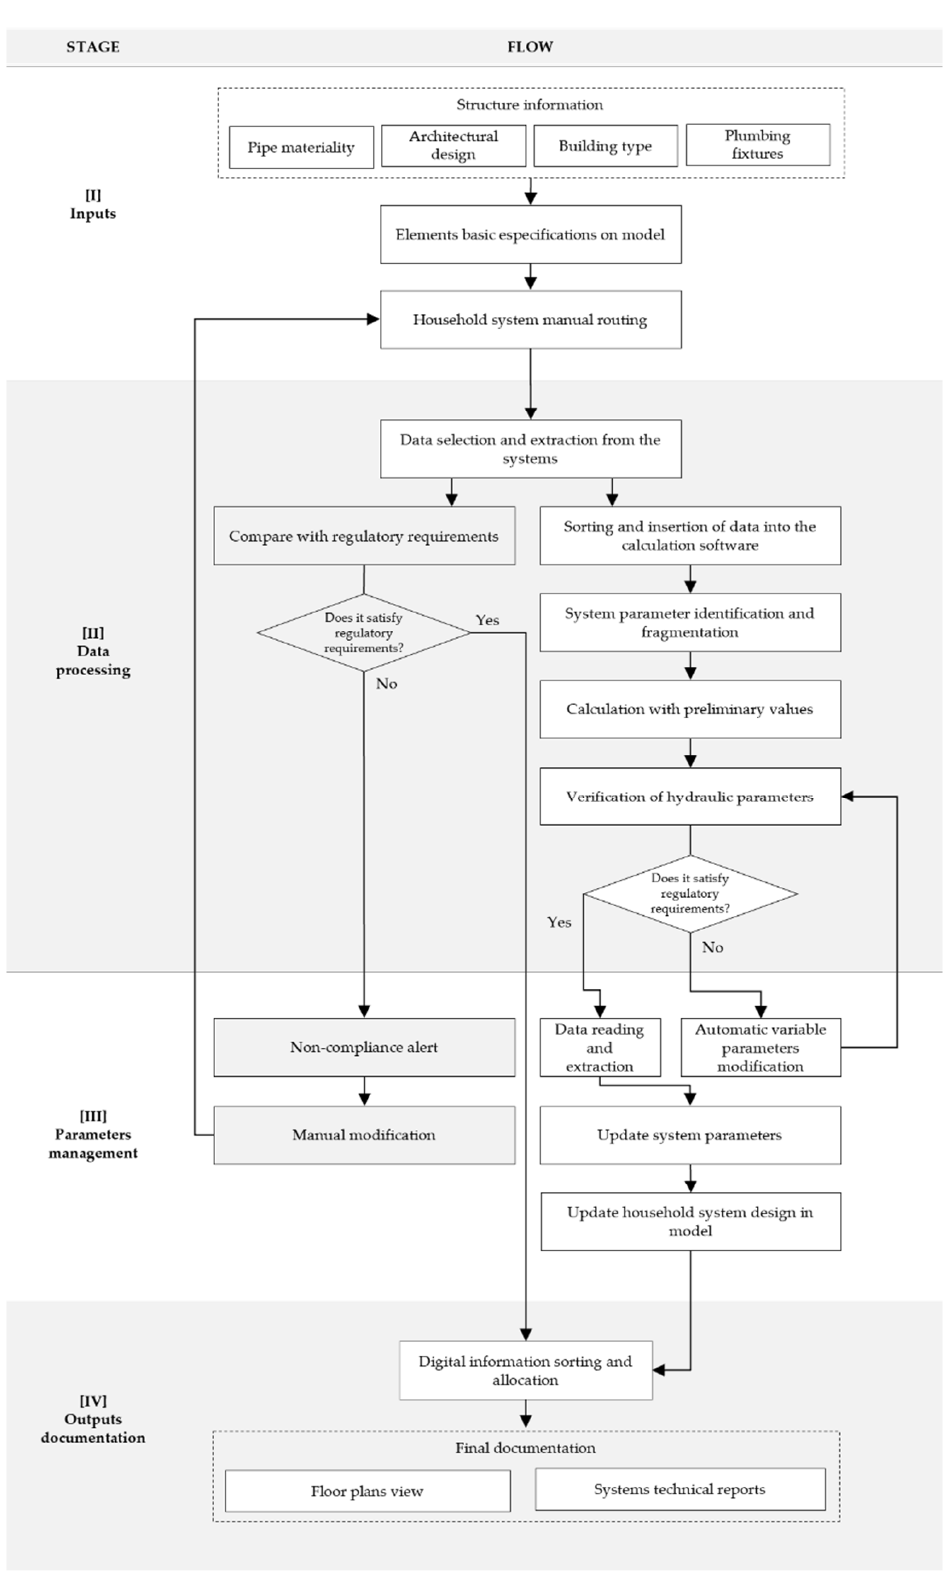
Figure 2. Workflow for drinking-water system (white boxes) and sewerage (grey boxes) design au- tomation.